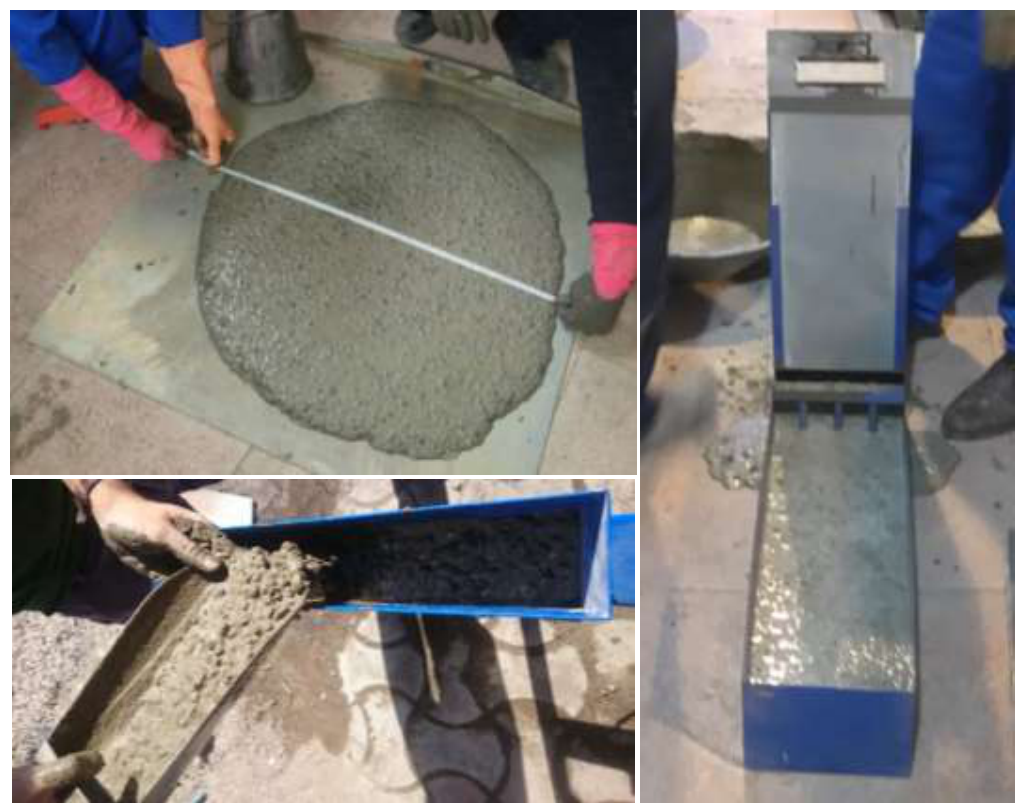
Figure 2. Self-compacting concrete